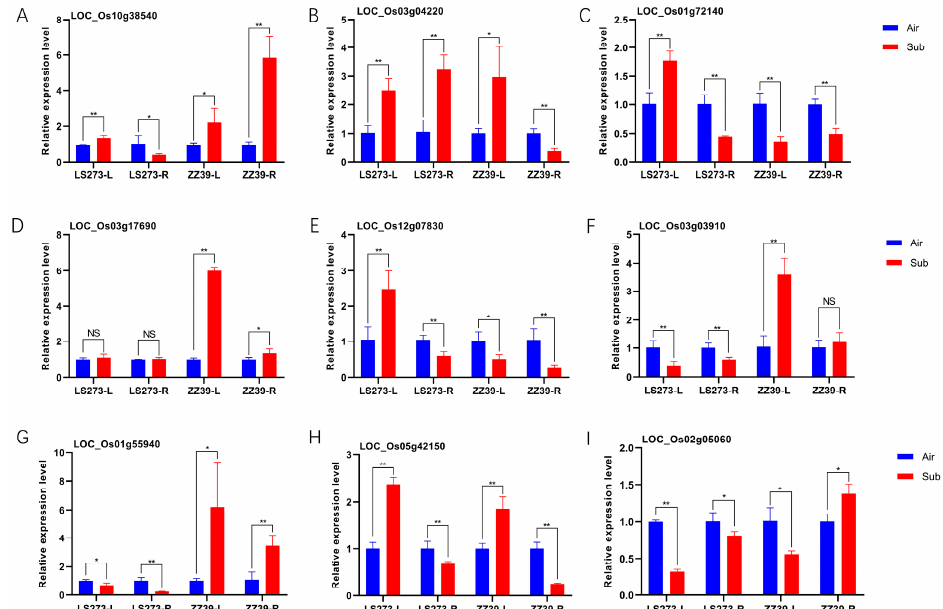
Figure 8. Quantitative real-time PCR (q-PCR) determination of antioxidant-related genes in differ- ent parts of varieties ( A – F ). Quantitative real-time PCR (q-PCR) to determine auxin-related genes in different parts of various varieties ( G – I ). **: significant at the 0.01 probability level ( p < 0.01); *: sig- nificant at the 0.05 probability level ( p < 0.05); NS: no significant difference. *: significant at the 0.05 probability level ( p < 0.05); NS: no significant